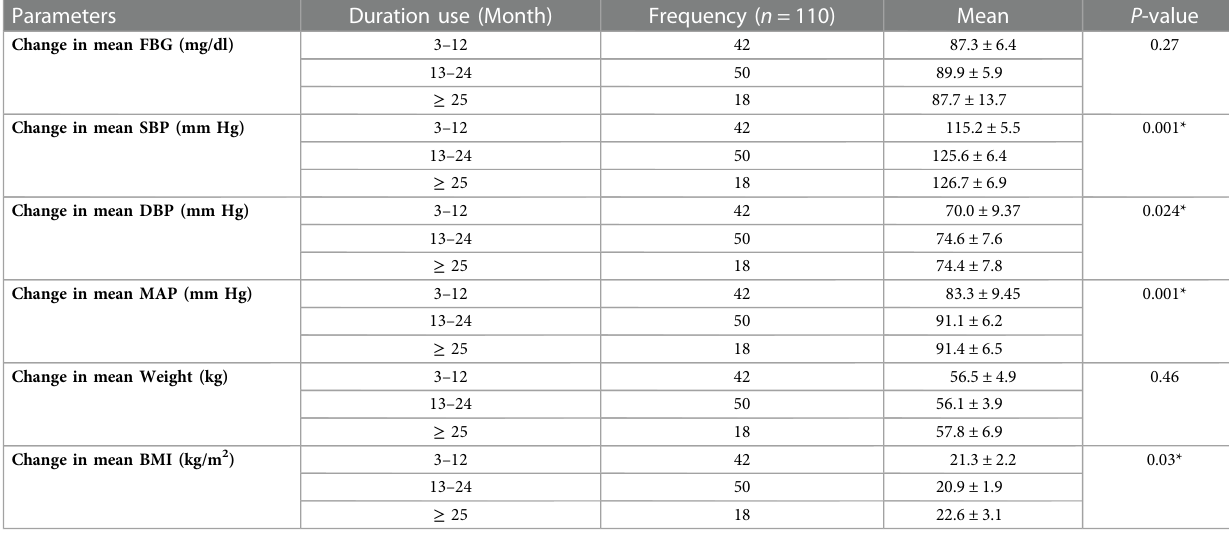
TABLE 3 Mean difference in serum FBG level, SBP, DBP, MAP, weight, and BMI among OCP users with relation to duration of stay on OCP utilization.